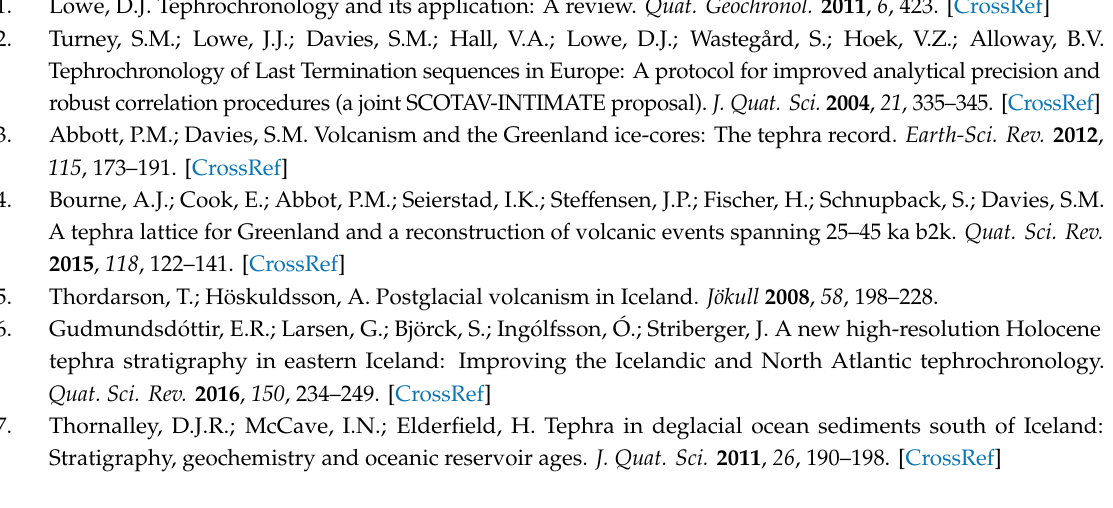
Table S1: Major oxides (weight %) in the analyzed ash shards from the sediment fraction of > 100 µ m in samples of the core